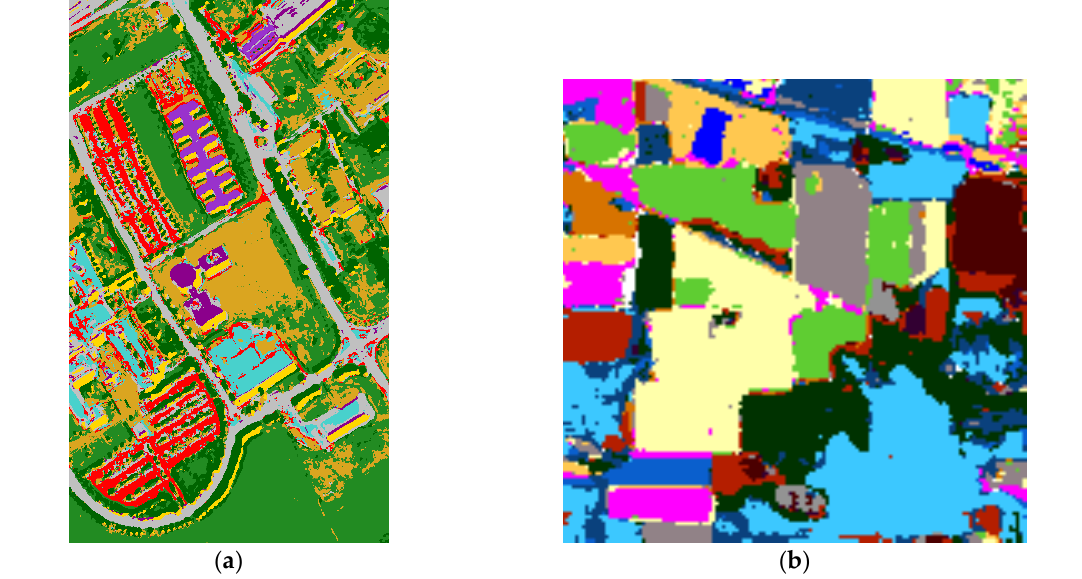
Figure 6. Spatial information-dominated classification result for Pavia University ( a ) and Indian Pines ( b ).